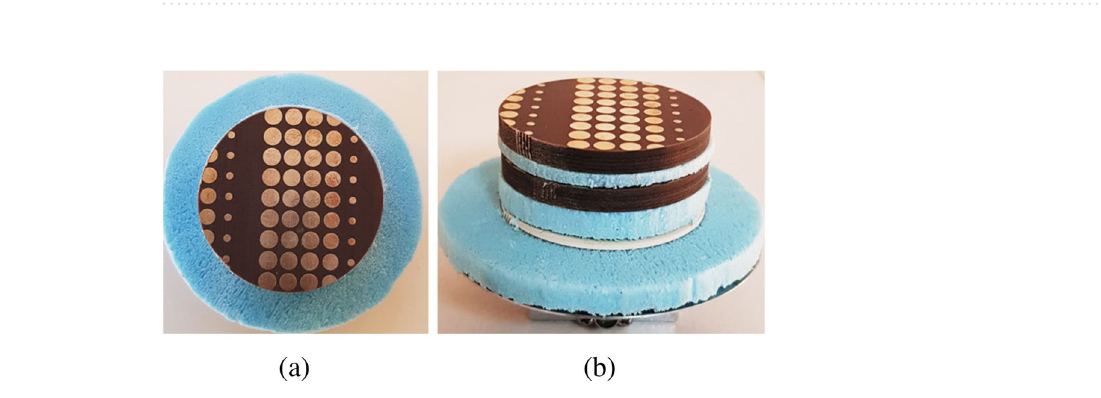
Figure 18. Measured and predicted elevation plane pattern cuts for an assembly of RCA and one PGM.